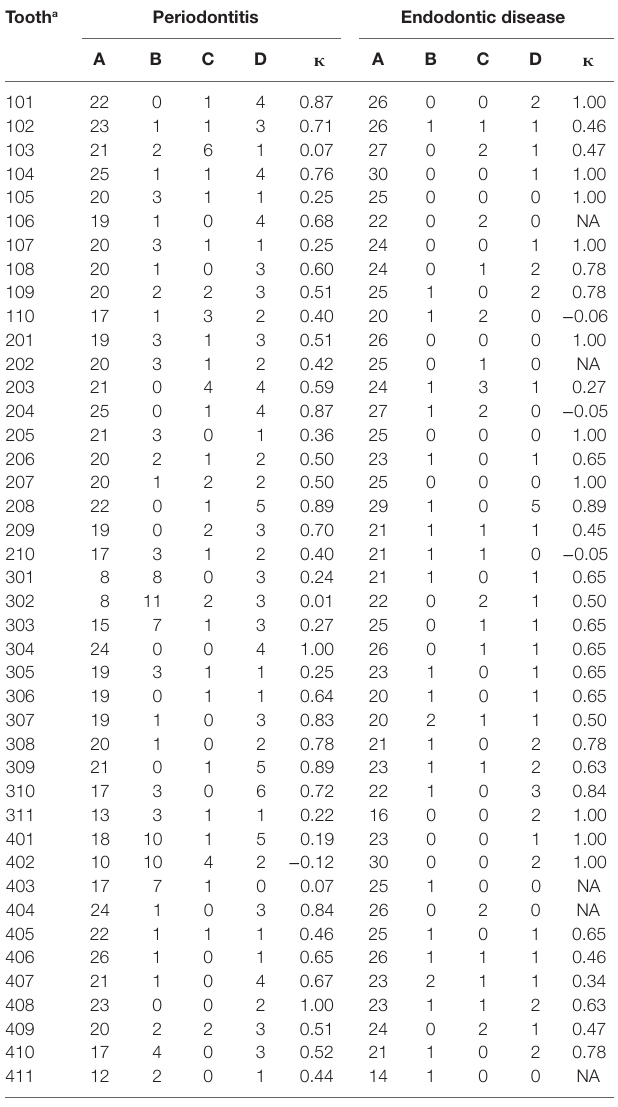
TaBle 1 | Method comparison by Observer